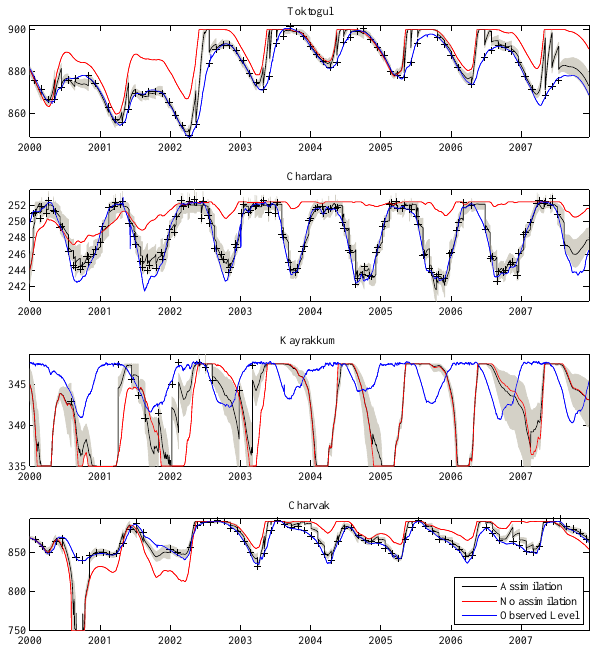
Fig. 7. Reservoir level simulation for the historical period (in mamsl): with assimilation of radar altimetry (black), without as- similation of radar altimetry (red), and observed in-situ water levels (blue) for an ensemble size of 50. The shaded area indicates the 2.5 and 97.5% quantile range of the ensemble, and the crosses are altimetry measurements. For interpretation of the color reference in this figure, the reader is referred to the electronic version of this article.